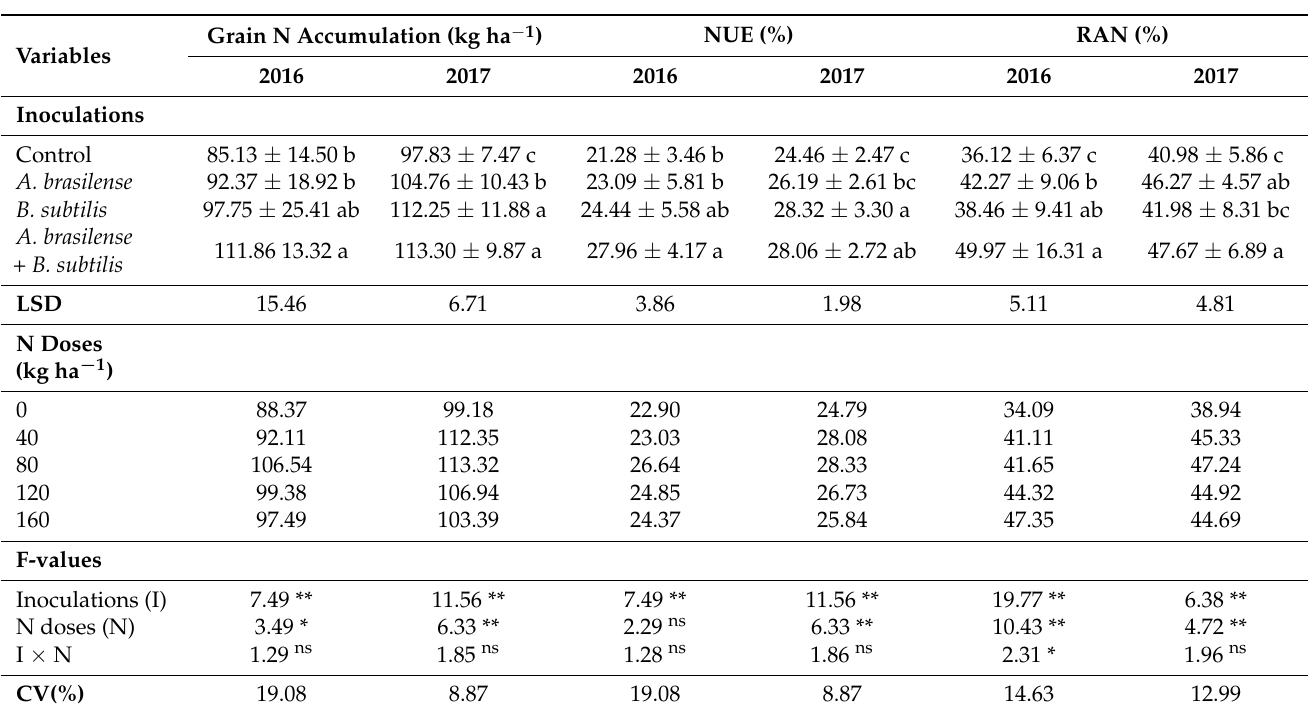
Table 2. Grain N accumulation, N use efficiency and applied N recovery as a function of inoculation with plant growth-promoting bacteria and N doses in the 2016 and 2017 wheat cropping